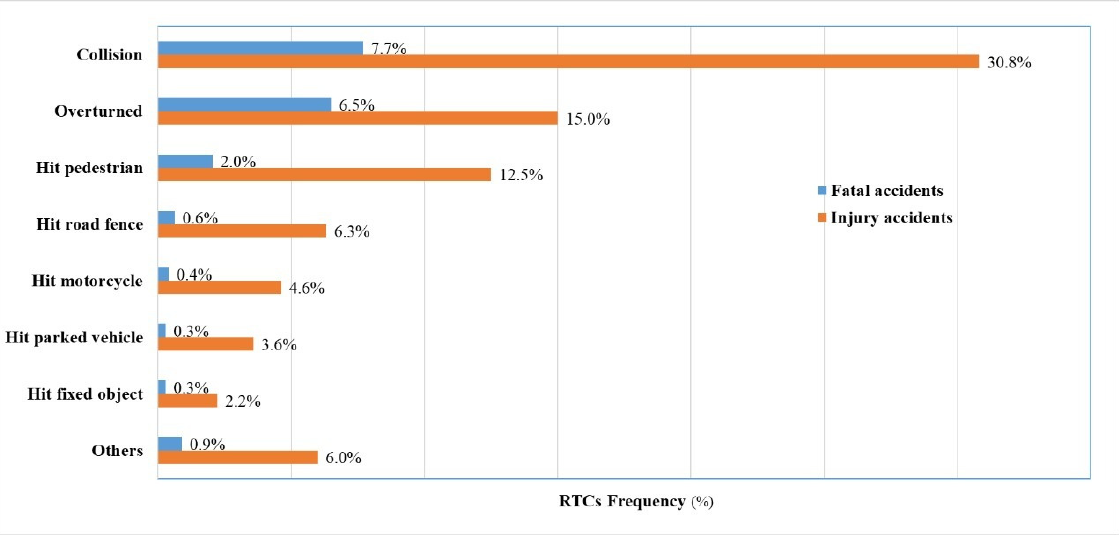
Figure 3. Crash frequency with crash types in the research area. (adopted from [63]).